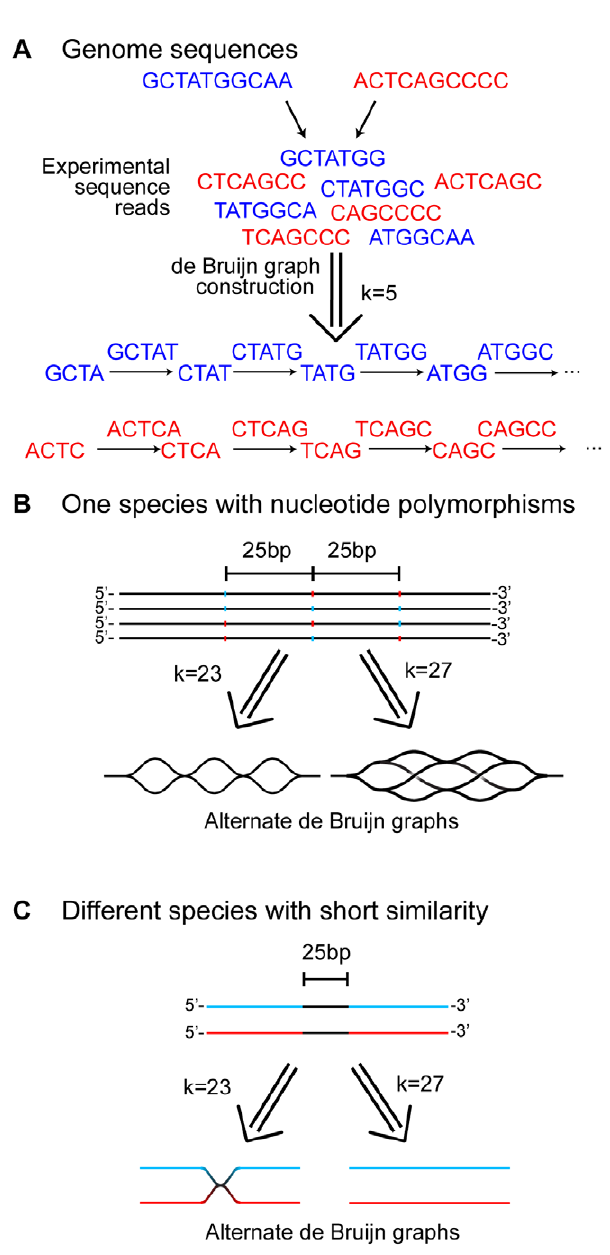
Figure 1. The de Bruijn graph assembly method and the influence of genomic variation on de Bruijn graph complexity. A) Shotgun sequences are produced from two different genomes (shown in blue and red at the top). Those sequences are used to construct a de Bruijn graph, where nodes are formed by all possible sequences of length k-1 (in this case 4 bases), which are connected by edges of length k (5 bases). Since there are no 4mers shared between these two example genomes, the resulting de Bruijn subgraphs are separate. B) Nucleotide polymorphisms are better resolved by short kmers. We consider a mixture of four genomes, each with three polymorphic positions separated by 25 bp. The identity at each polymorphic position is represented by either blue or red to indicate different nucleotides. At all other positions the genomes are identical. The de Bruijn graph that is constructed from this mixture of genomes using a kmer of 23 is shown on the left, where three independent bubbles form around each polymorphic position. The equivalent graph at k=27 is shown on the right, where three independent sets of bubbles overlap, forming a more complex and suboptimal graph structure. C) Short regions of similarity are better resolved by